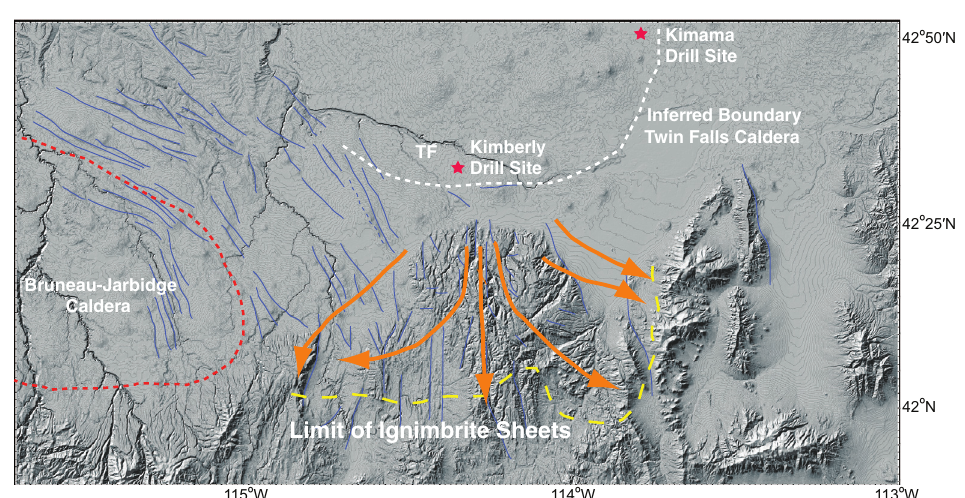
Figure 3. Shaded relief map of Twin Falls area, with 10-m contours calculated from NASA 10-m DEM data in GeoMapApp. Blue lines show mapped faults and lineaments mapped in 10-m data. Orange arrows show flow directions on ash flow tuff sheets in the Cassia Mountains, mapped by McCurry et al. (1996), with southern extent of sheets marked by long-dashed yellow line at the bottom. Bruneau-Jarbidge caldera marked by dashed red line. Southern margin of the Twin Falls caldera complex, inferred from regional Bouger gravity anomaly, shown with short-dashed white line. Drill sites marked with red stars; TF=city of Twin